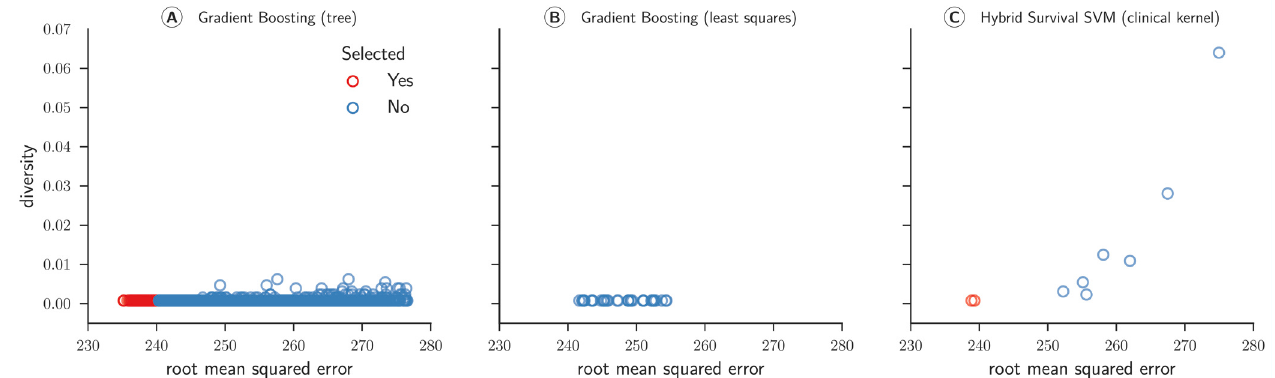
Figure 7. Root mean squared error (RMSE) and diversity score of 1,281 regression models for sub challenge 1b. The RMSE was evaluated by cross-validated models on the training data from the ASCENT-2, VENICE, and MAINSAIL trial. Diversity was computed based on Pearson’s correlation coefficient between residuals on the training